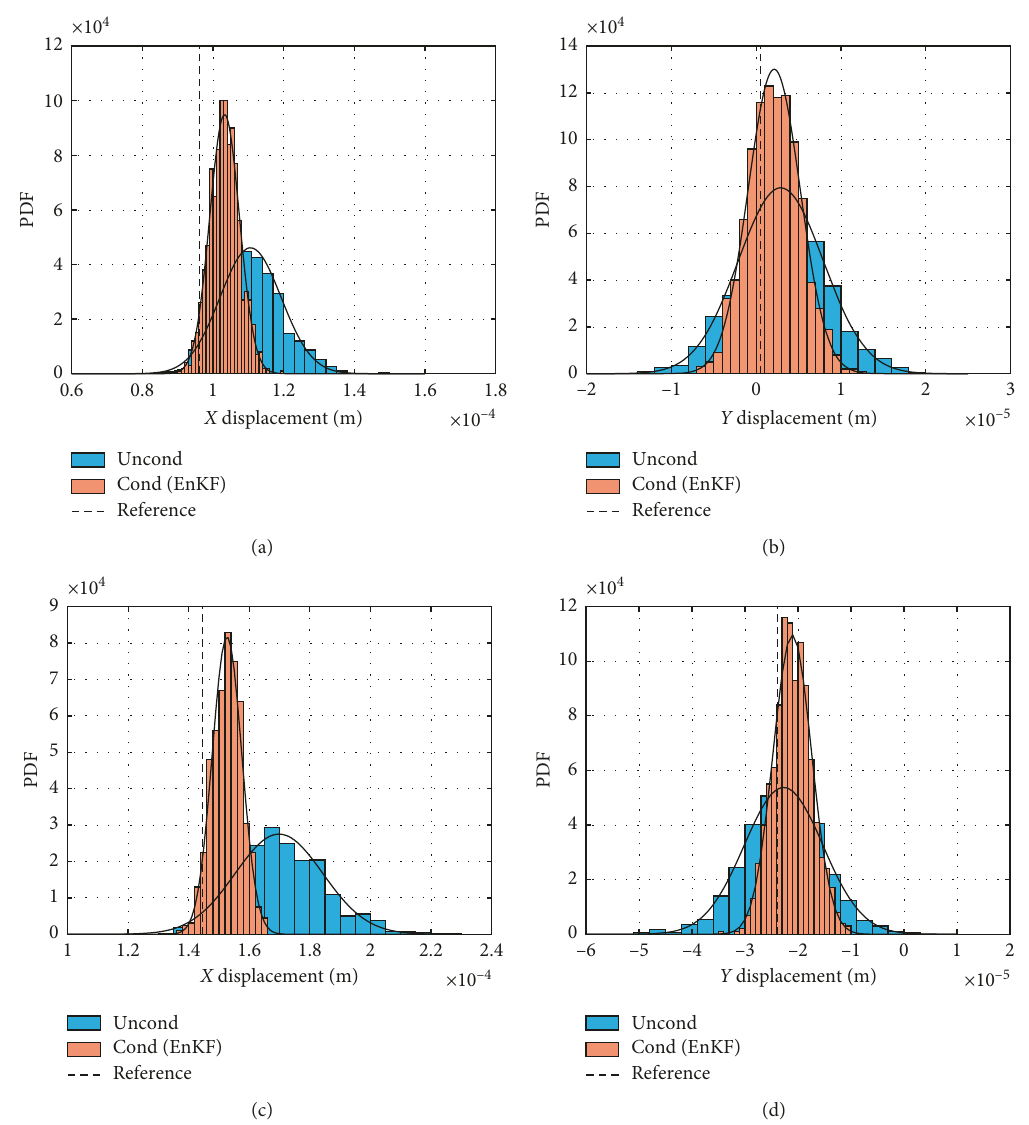
Figure 9: PDF of target point displacements in excavation steps 2-3: comparison between unconditional simulation and conditional simulation based on displacement measurements. (a) Second layer excavation ( X ), (b) second layer excavation ( Y ), (c) third layer excavation ( X ), and (d) third layer excavation ( Y